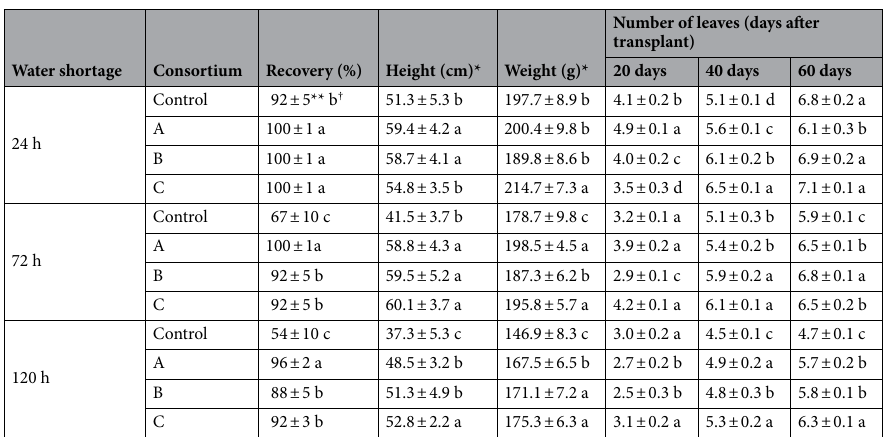
Table 5. Recovery and growth of tomato plants inoculated with rhizobacterial consortia and exposed to water shortage stress at different time intervals (24, 72 and 120 h) prior to transplant to definitive substrate. *Growth was measured after 60 days since transplant. **Values are means ± standard deviation of 50 seedlings per treatment. † Different letter in the column denote significant differences ( P ≤ 0.05) by ANOVA followed by Tukey’s post-hoc